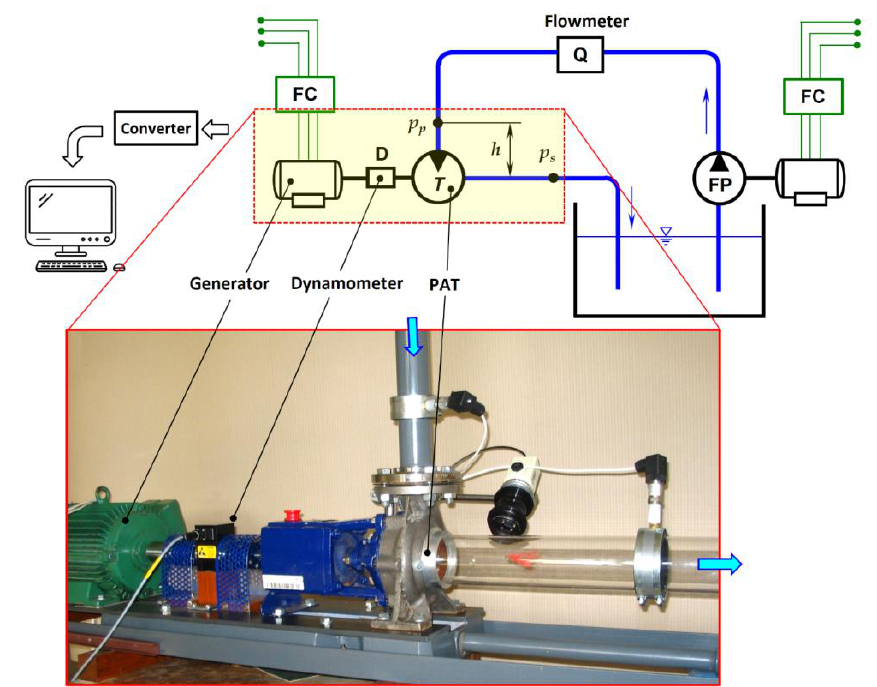
Figure 8. The hydraulic circuit scheme for testing PAT (Turbine variant shown in the photo): Q: flowmeter; FP: feed pump; PAT: pump as turbine; D: dynamometer; FC: frequency converter.